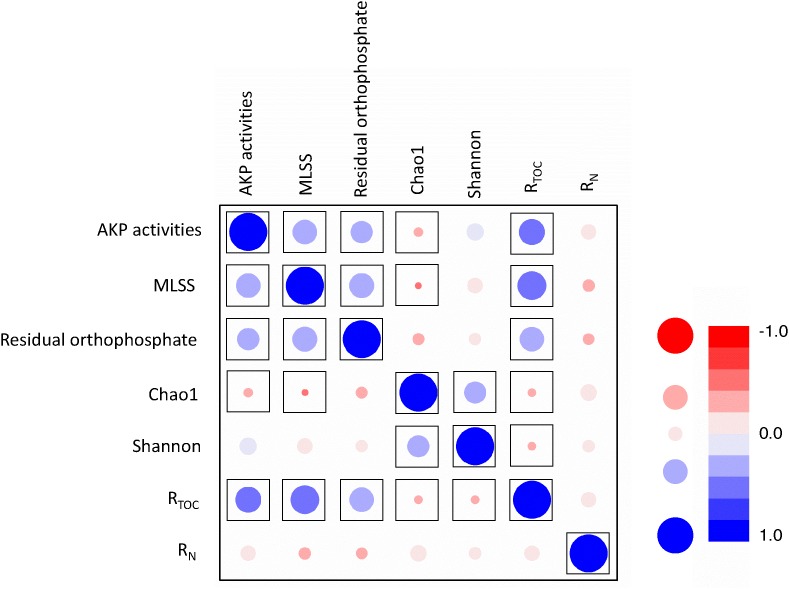
Correlation analyses between MLSS, AKP activity, residual orthophosphate, TOC removal, and ammonia removal. RN represents ammonia removal efficiency and RTOC represents TOC removal efficiency. The color shading and bubble size refer to linear coefficients, and framed points represent the significant correlation with p < 0.05.